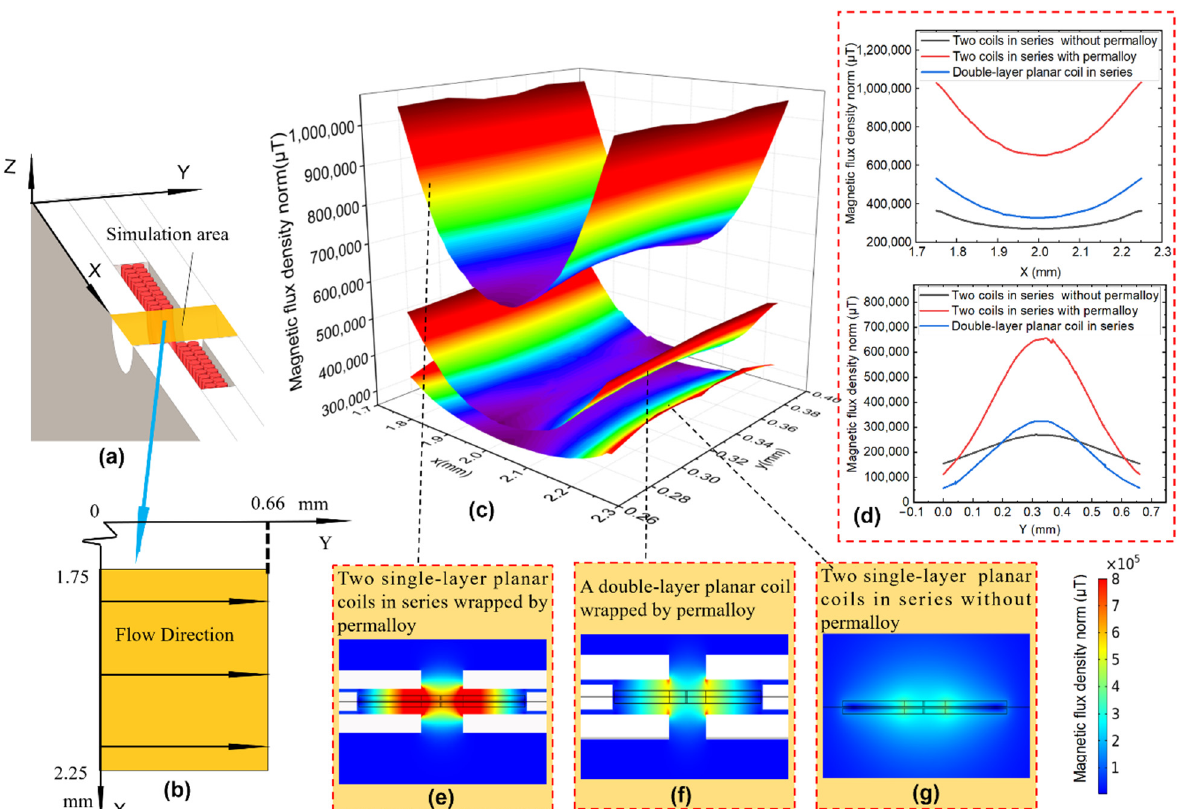
Figure 4. Magnetic field simulation results: ( a ) simulation area, ( b ) simulation area boundary, ( c ) magnetic flux density norm of different structure, ( d ) radial and axial magnetic field distribution of the coil, ( e ) magnetic field distribution diagram of two planar coils in series wrapped by permalloy, ( f ) magnetic field distribution diagram of a double-layer planar coil wrapped in permalloy, ( g ) magnetic field distribution diagram of two planar coils in series that are not wrapped by permalloy.